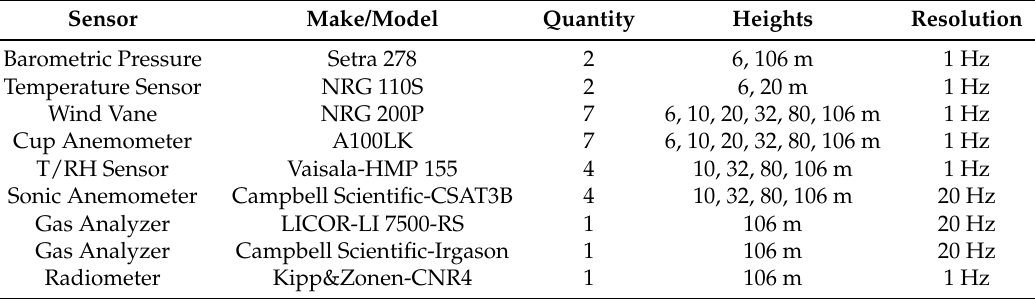
Table 1. List of instruments on the met tower.